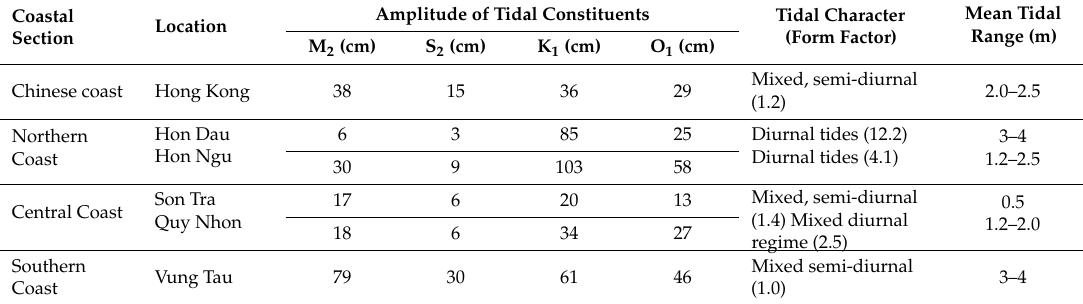
Table 1. Tidal characteristics along the coast of Vietnam